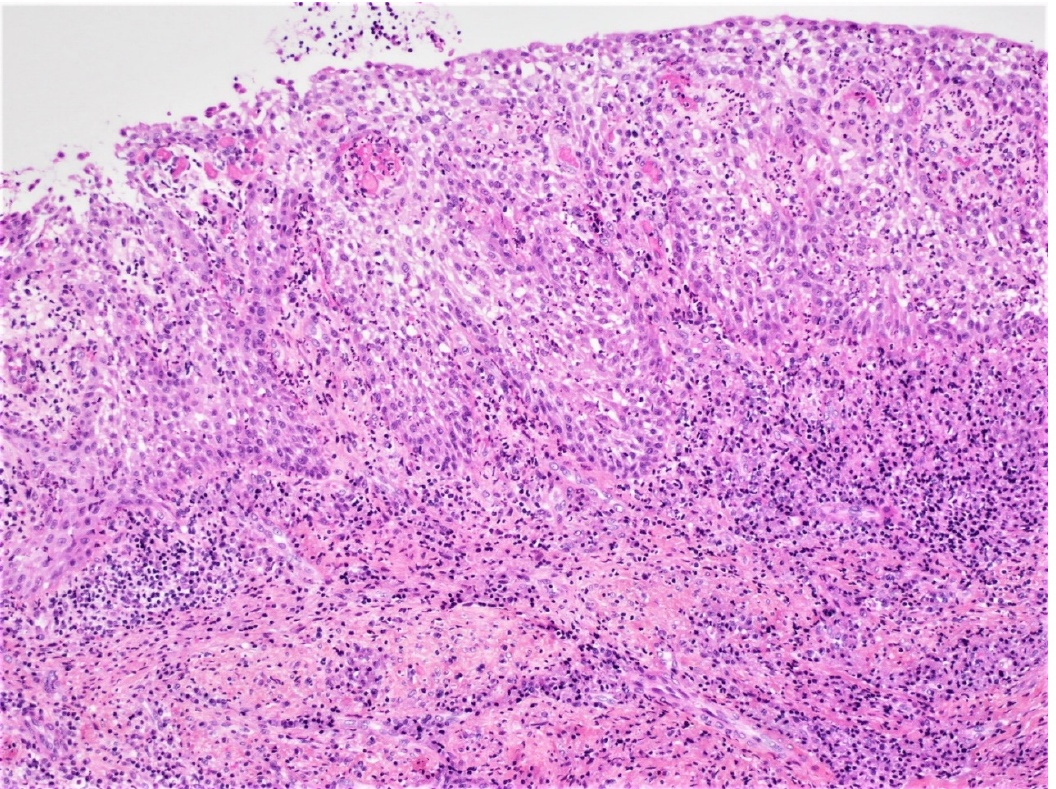
Figure 15. Non-keratinized spongiotic squamous epithelium presenting hyperplastic rete ridges. The fibrous wall contains a lymphoplasmocytic infiltrate (H&E, ×10).